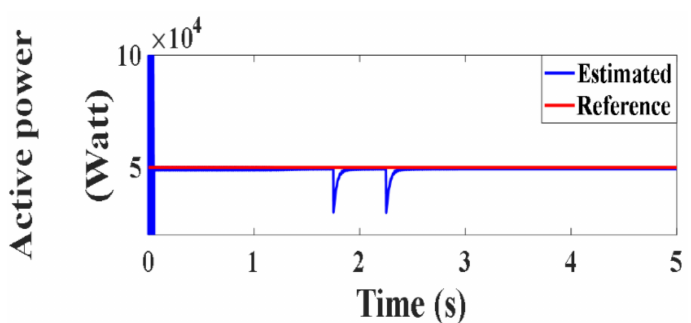
Figure 10. Active power under SVOC (Watt).